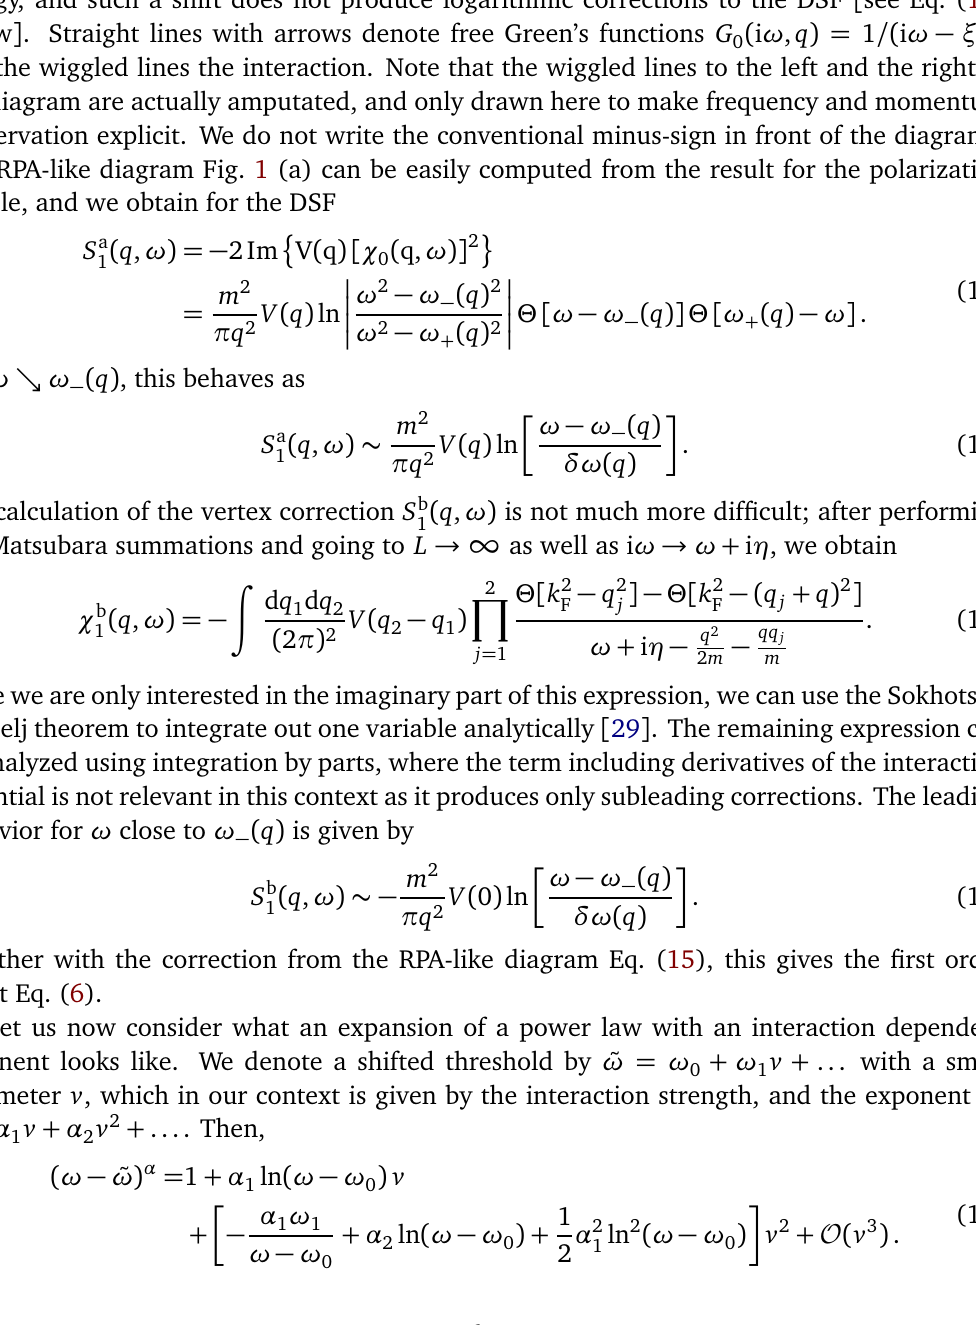
Figure 1: Feynman diagrams for the polarization in first order in the interaction. The capital labels are a multi-index, e.g. Q are summed